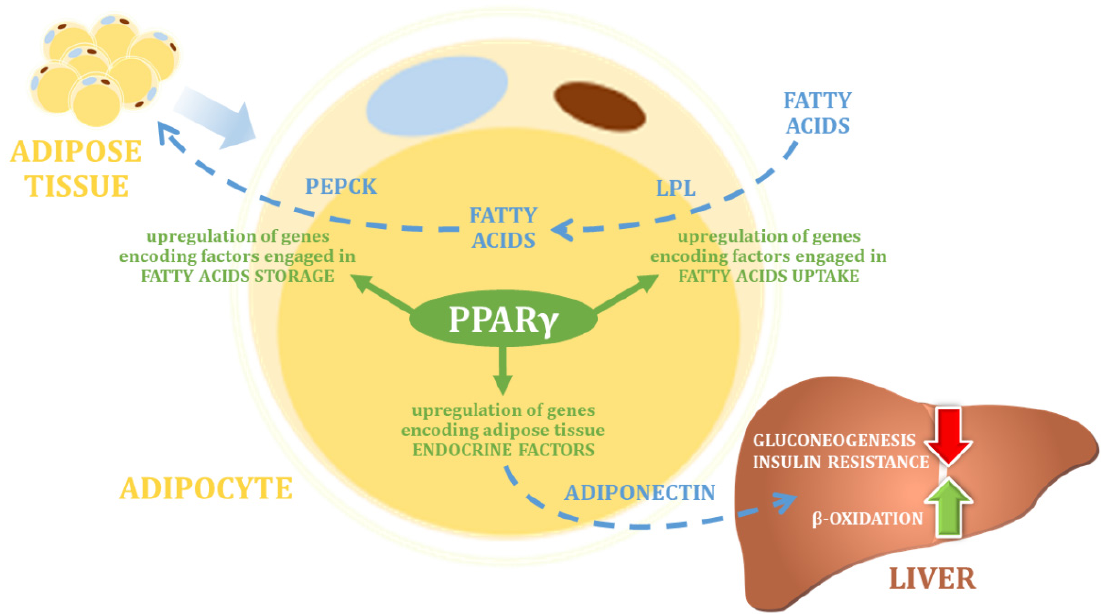
Figure 2. The main physiological function of PPAR γ (own elaboration, after: Skat-Rørdam et al. 2018 [78]). PEPCK—Phosphoenolpyruvate carboxykinase; LPL—lipoprotein lipase.